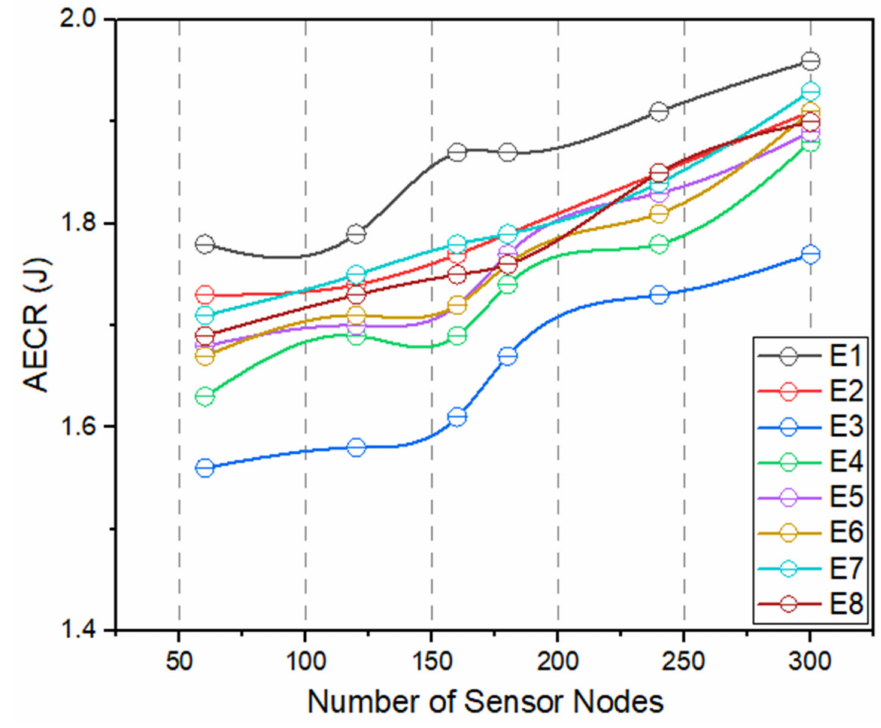
Figure 8. AECR and number of sensor